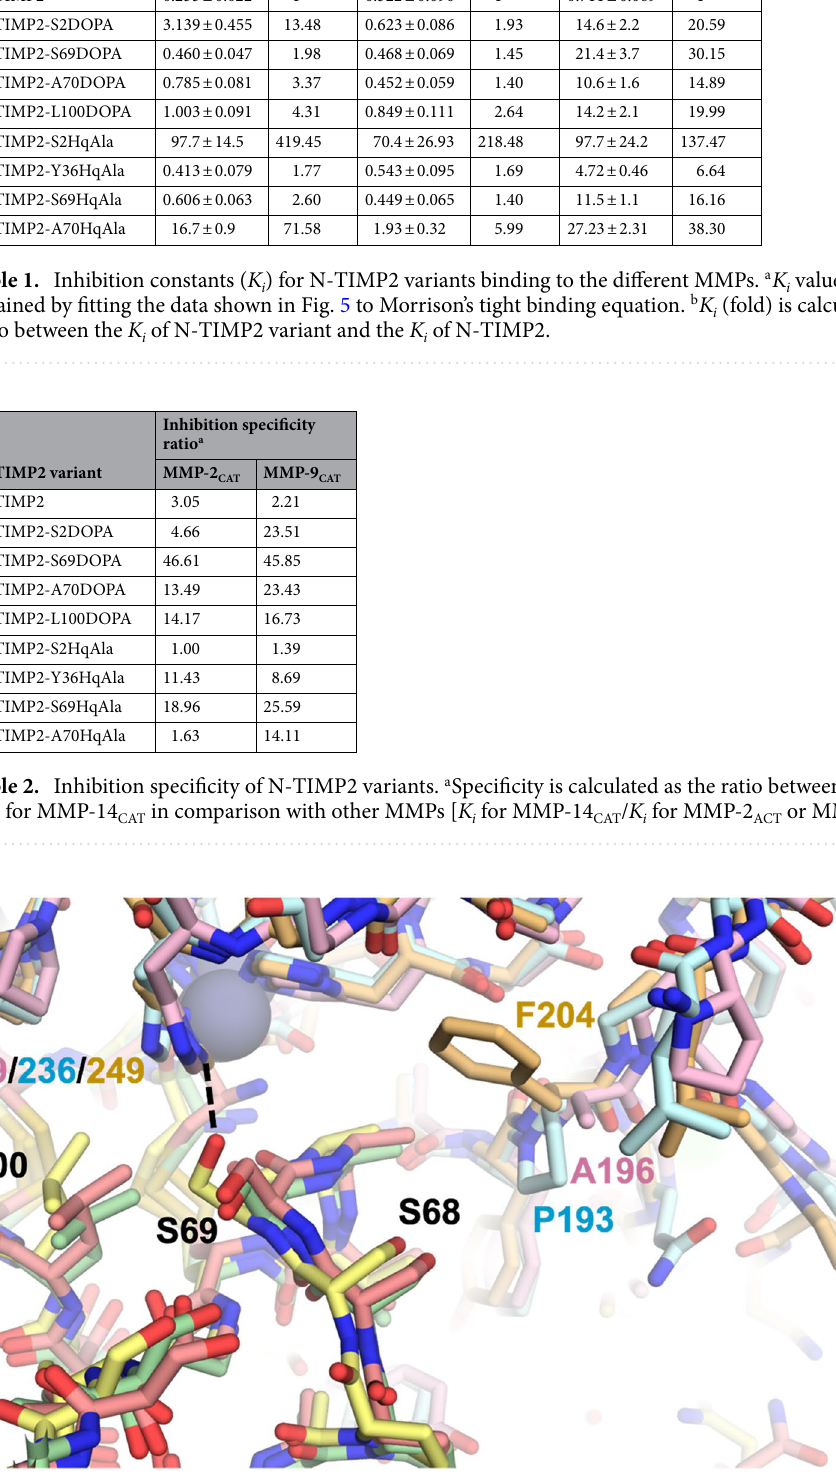
Figure 6. Structural comparison of MMP/N-TIMP2 complexes. Modeled complexes of N-TIMP2 with each MMP are shown, with MMP-2/N-TIMP2 in pink/salmon, MMP-9/N-TIMP2 in pale cyan/pale green, and MMP-14/N-TIMP2 in yellow orange/pale yellow. The MMP catalytic Zn 2+ is shown as a gray sphere. The H-bond between N-TIMP2-S69 and MMP-14-H249 is shown as a dashed black line, and the relevant residues in both proteins are